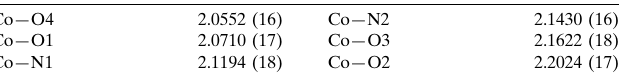
Selected bond lengths (A˚ ).